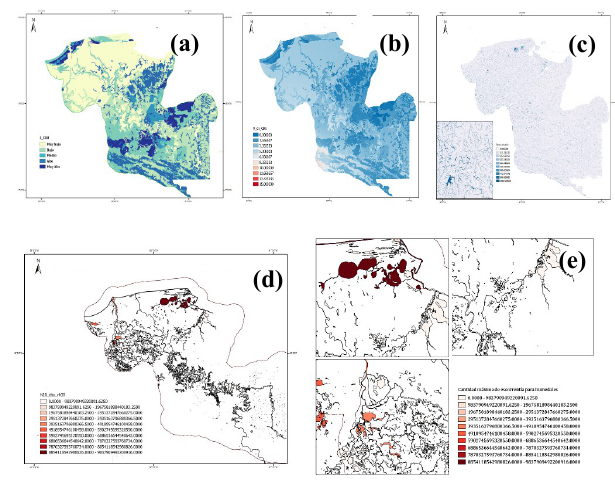
Figure 3. Resulting maps for the lower part of the basin: Amount of rain absorbed by the soil (a) , runoff amount by pixel (b), flow accumulations weighted by surface runoff (c), wetlands classification according to the amount of water flowing into them (d and